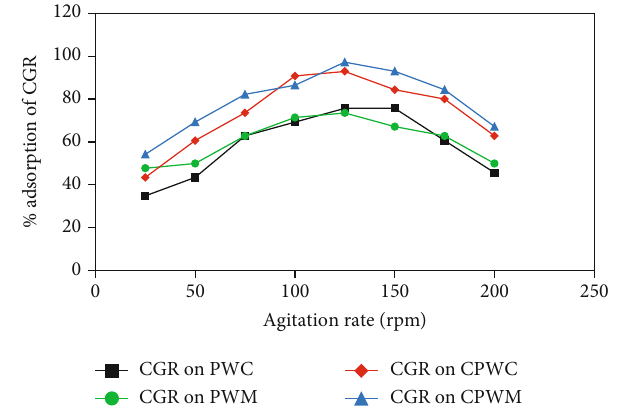
Figure 10: Optimization of agitation